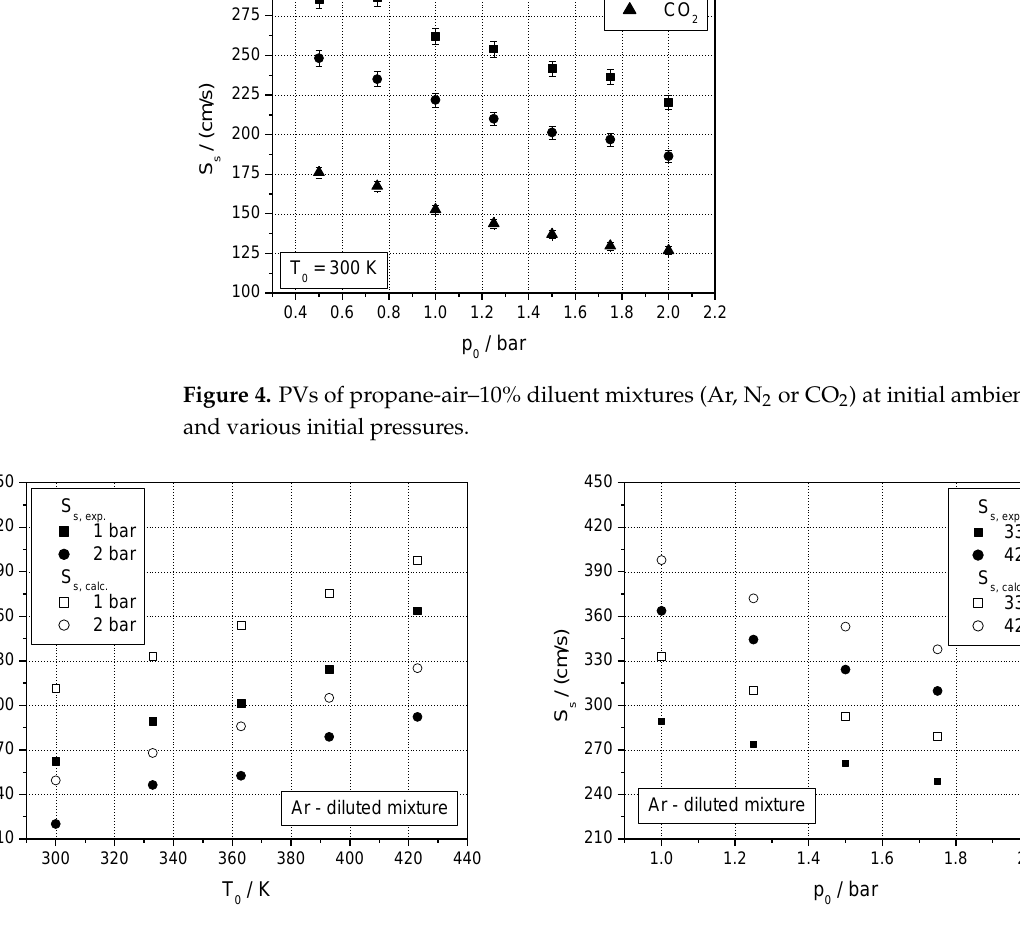
Figure 5. Comparison of experimental and calculated PVs of stoichiometric C 3 H 8 -air diluted with 10% Ar at: ( a ) various initial temperatures; ( b ) various initial pressures.